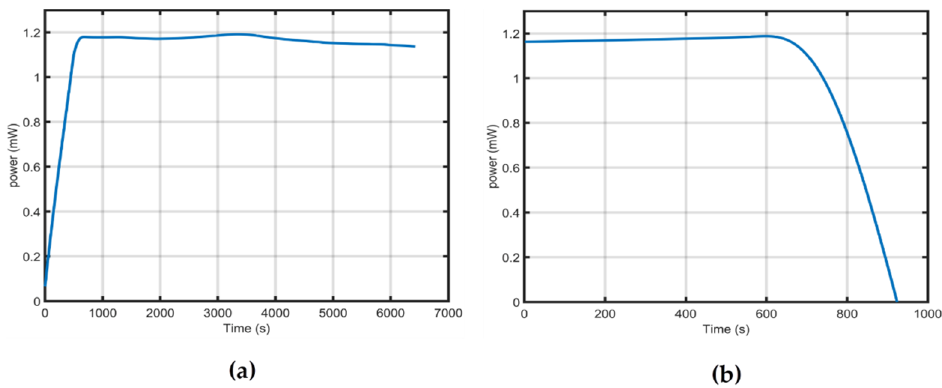
Figure 23. Voltage drop rate during the harvesting (closed-circuit).